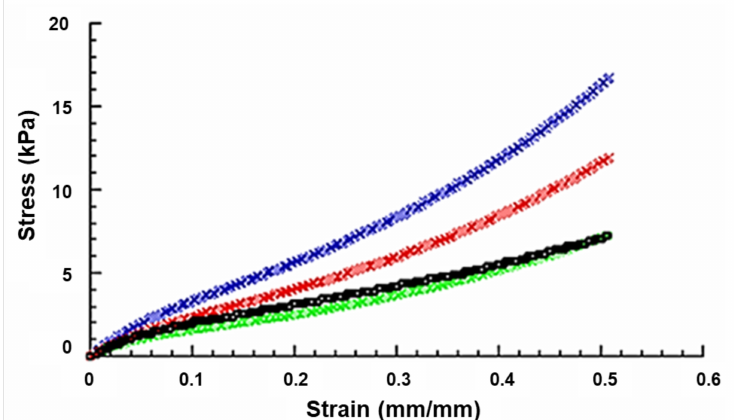
Figure 1. Typical stress–strain curves obtained from compression tests on ChS (Blue), ChS+EAK (Red), ChS+EAK-IKVAV (Black), and ChS+EAK-YIGSR (Green) scaffolds (rate of 1 mm/min, final strain of 50%).